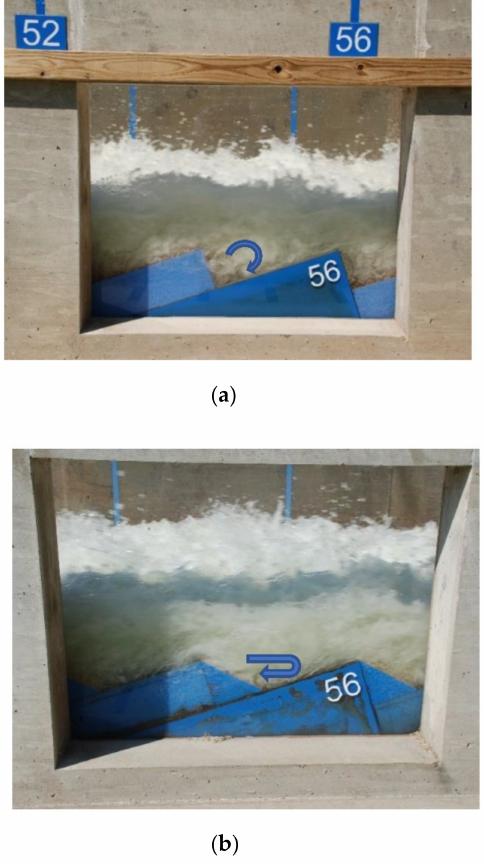
Figure 5. Observed circulation patterns in stepped chutes with ( a ) vertical face steps and ( b ) beveled face